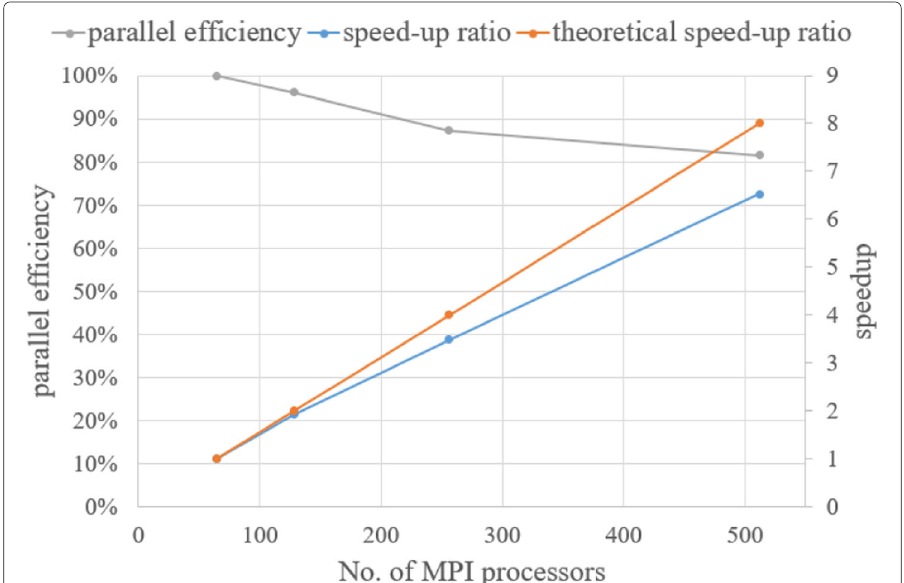
Fig. 25 Parallel efficiency and speed-up ratio for different number of processes